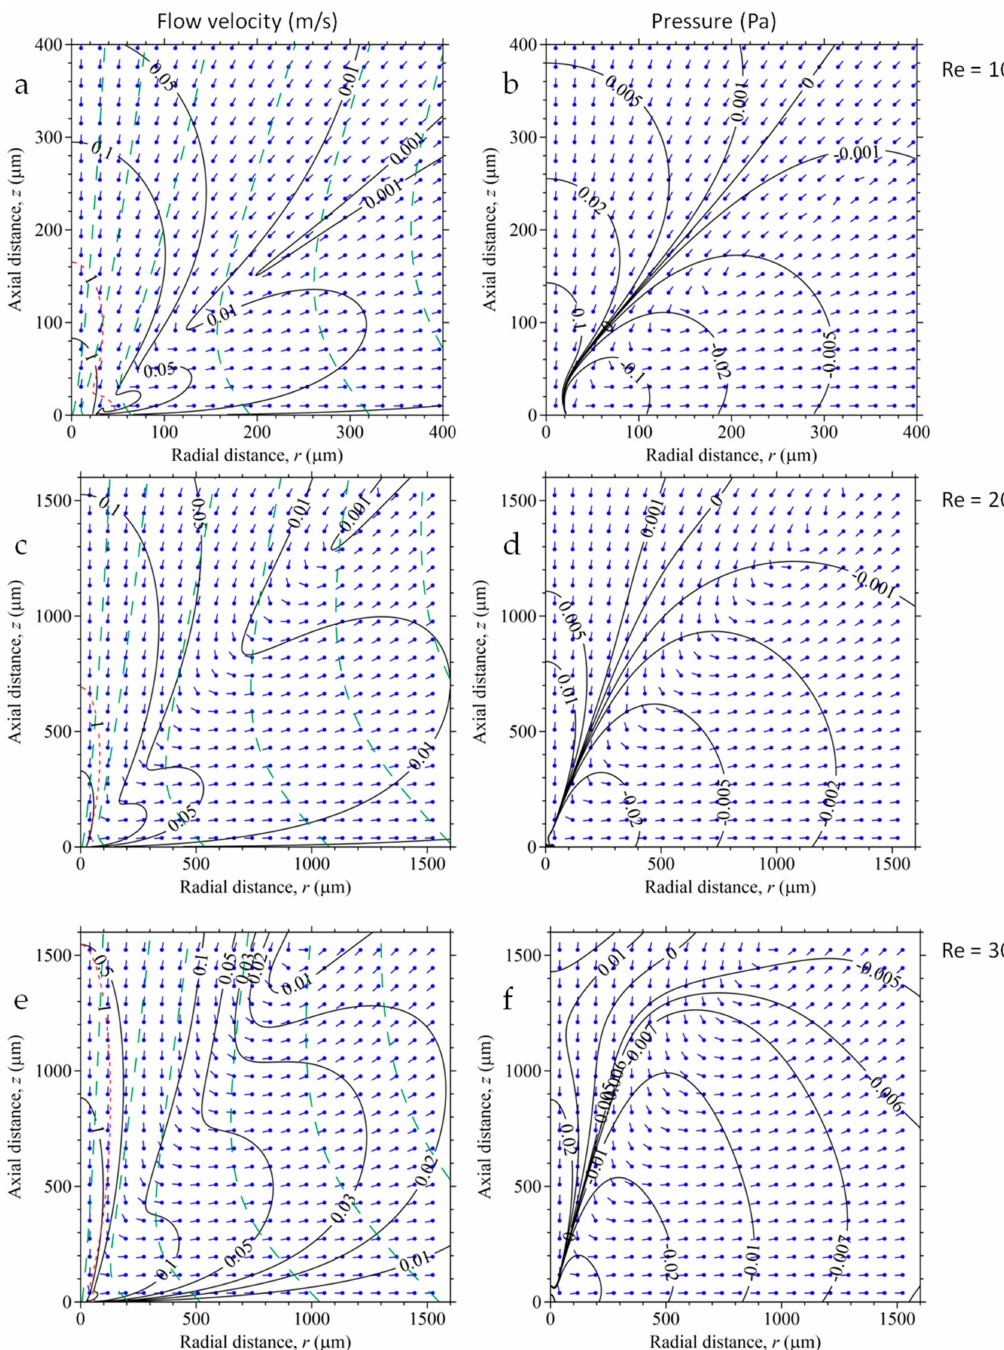
Figure 8. Calculated gas-dynamic fields of the absolute value of flow velocity (left: a , c , e ) and pressure (right: b , d , f ) at Reynolds number Re: ( a , b ) 10; ( c , d ) 20; ( e , f ) 30. Blue flags indicate the direction of the flow velocity vector. Contour lines: numerical calculation (black curves); Landau’s similarity solution (green dashed